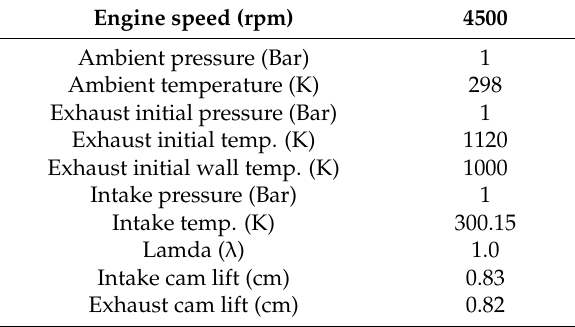
Figure 3. Single-cylinder engine model. Table 4. Initial conditions for simulation